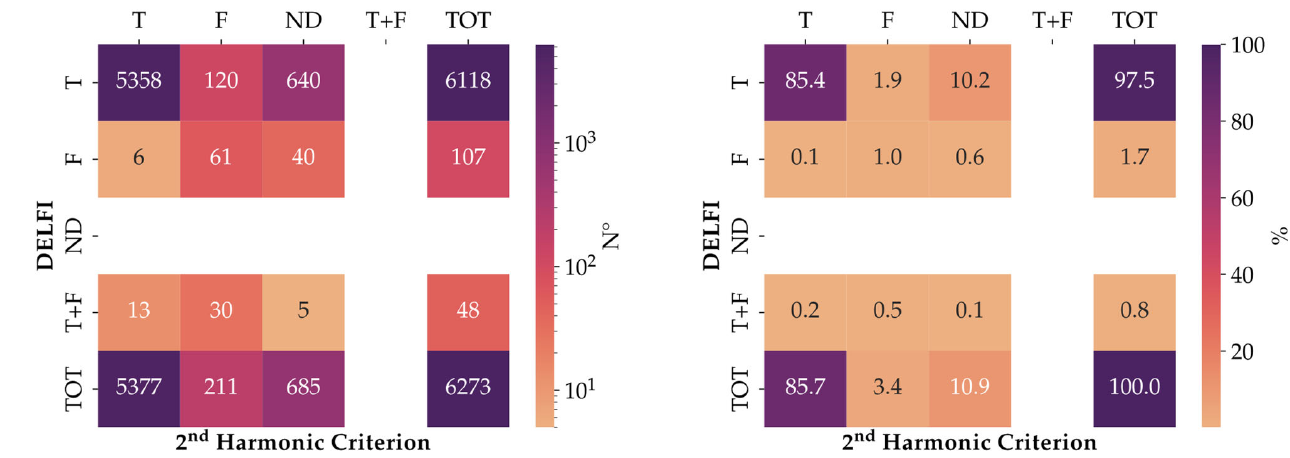
Figure 11. Validity assessment: 2nd Harmonic and DELFI outcomes for the IN Subset.